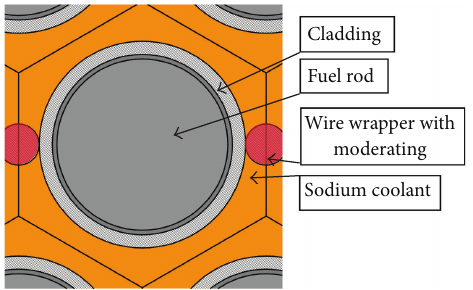
Figure 2: Unit cell out of a fuel element based on the European fast reactor (EFR) design with introduced moderation layer.